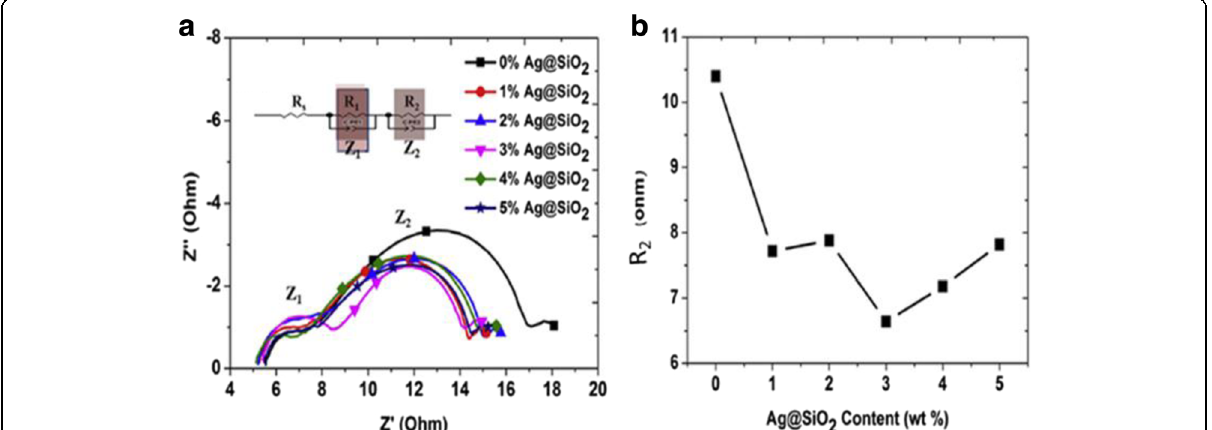
Fig. 25 a Nyquist plots obtained from the EIS of DSSCs with varying Ag@SiO 2 content (inset shows the equivalent circuit). b R2 ohm with respect to the